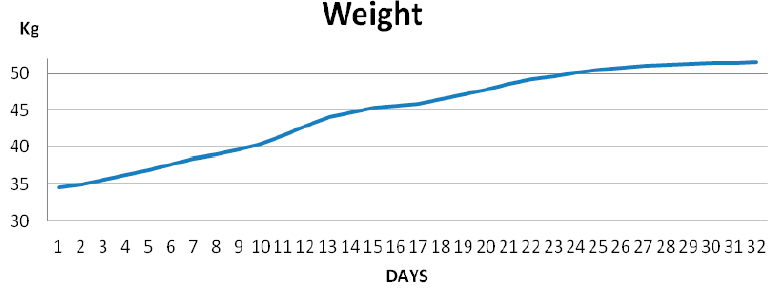
Figure 18. Average evolution of the weight (kg) of four beehives over 32 days.